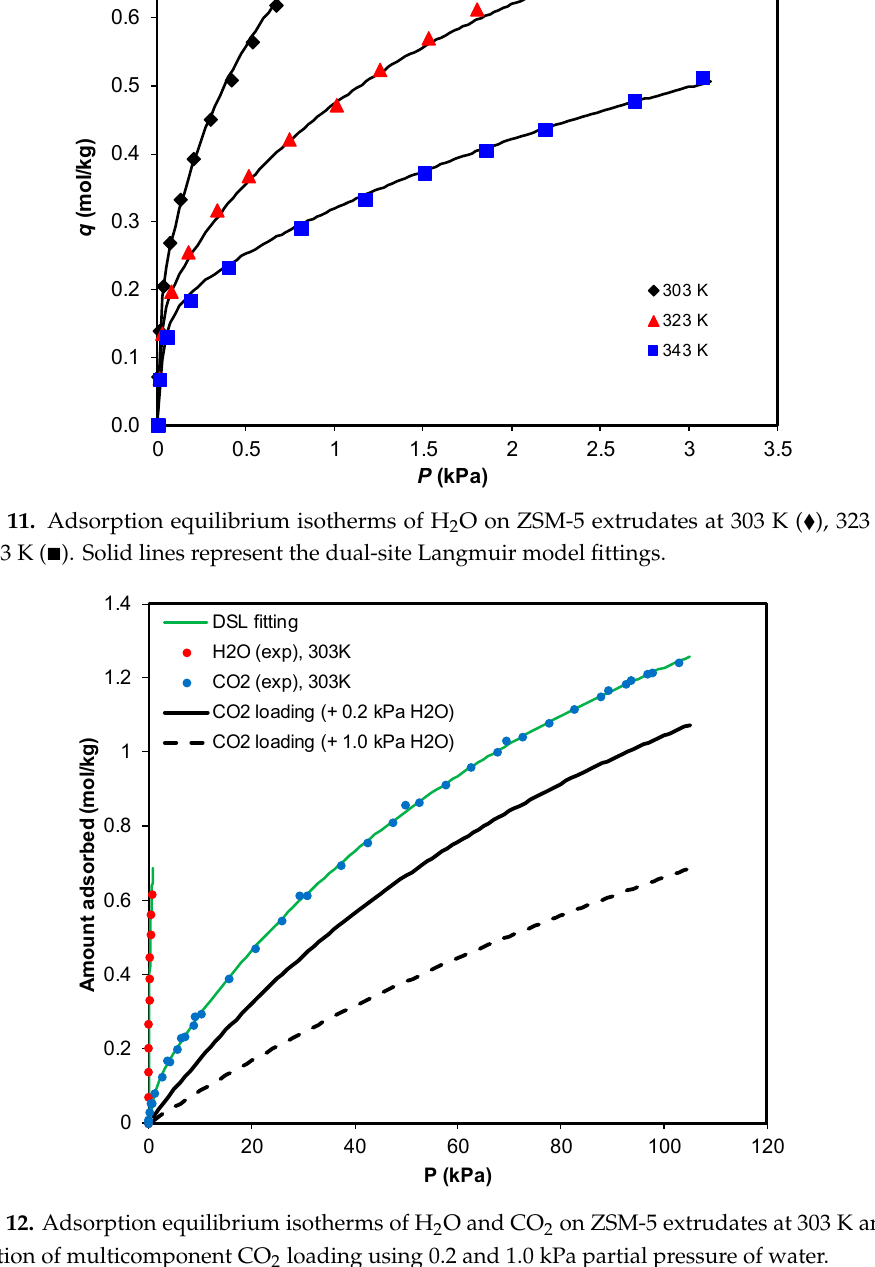
Figure 12. Adsorption equilibrium isotherms of H 2 O and CO 2 on ZSM-5 extrudates at 303 K and the prediction of multicomponent CO 2 loading using 0.2 and 1.0 kPa partial pressure of water.